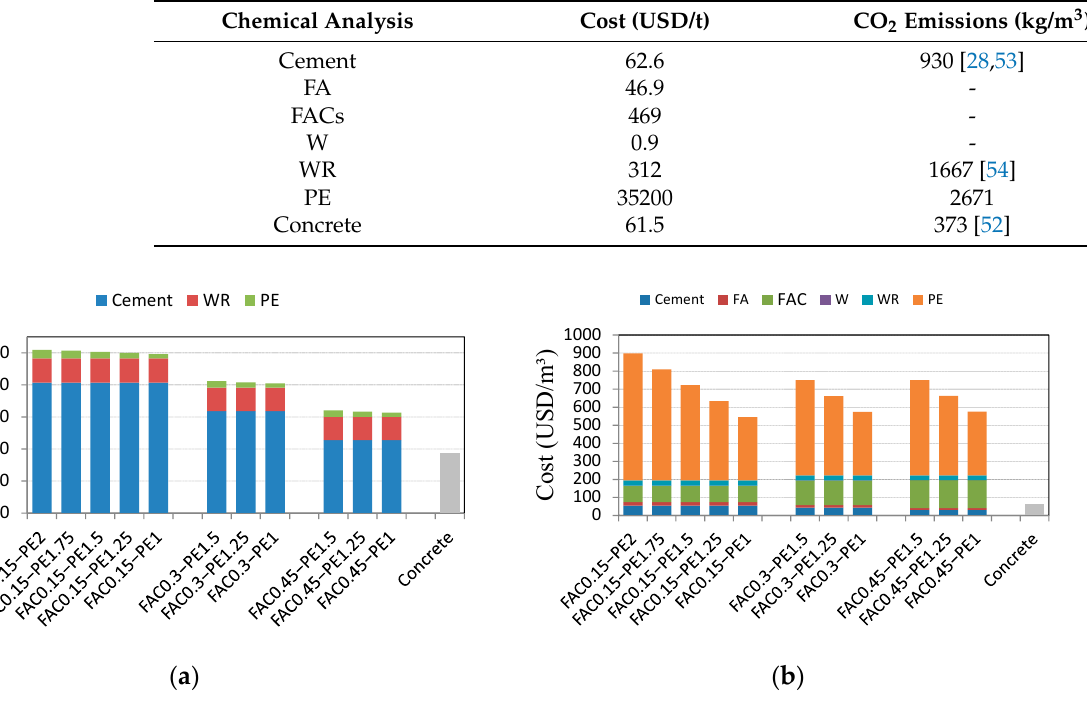
Figure 18. Cost and CO 2 emissions of GLECCs. ( a ) Carbon emission; ( b ) cost [28,52–54].